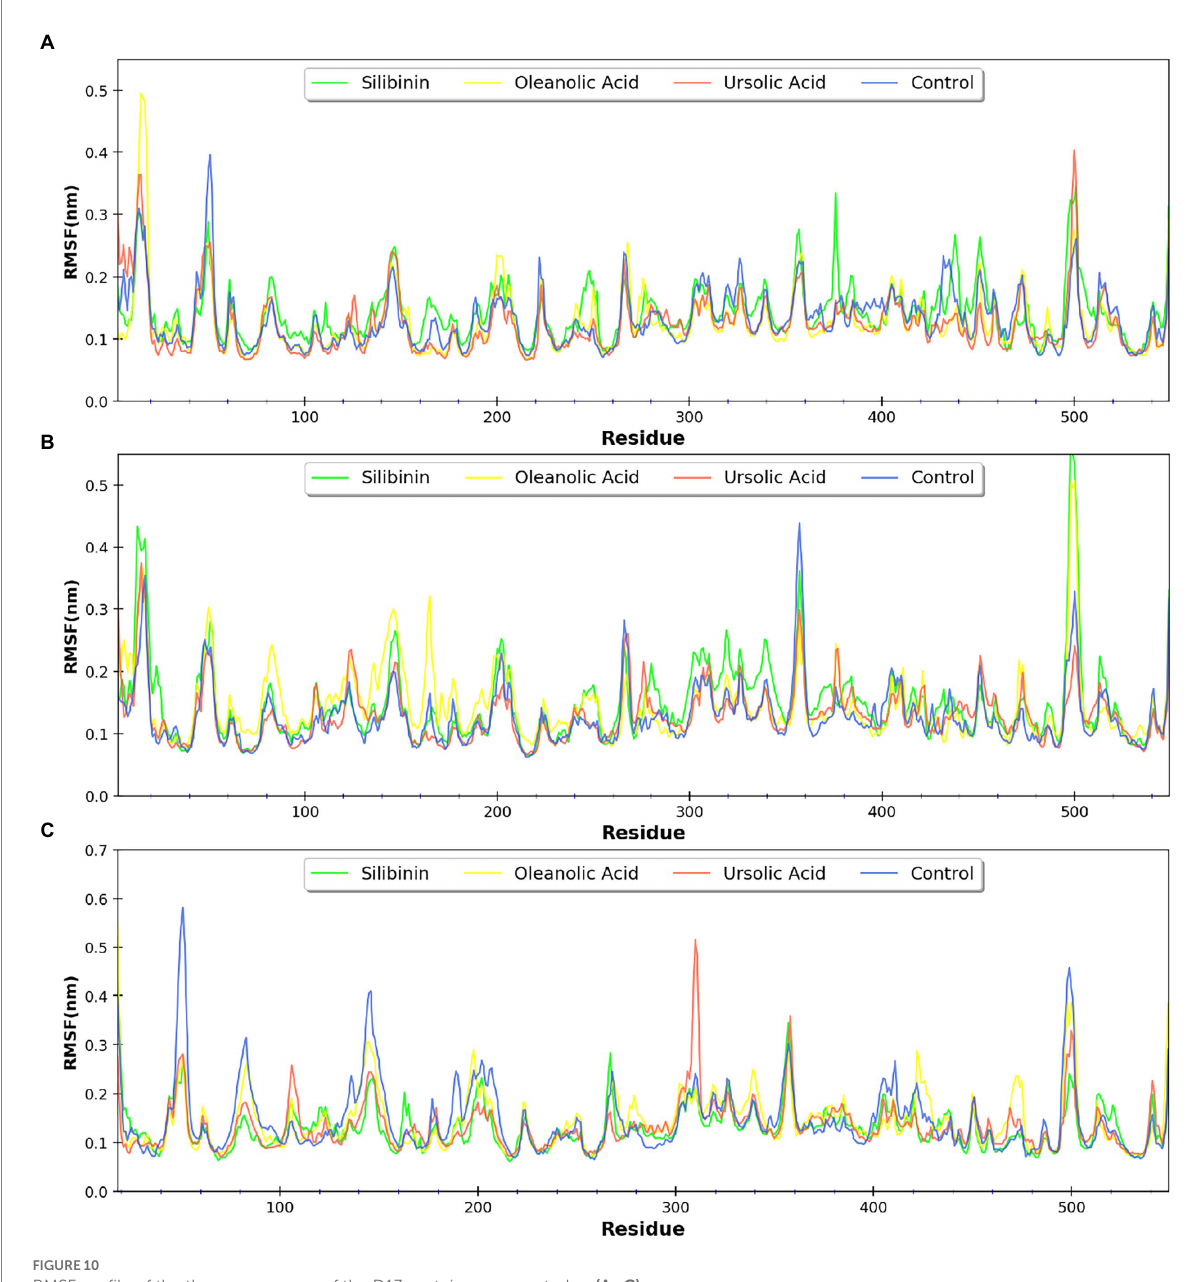
FIGURE 10 RMSF profile of the three monomers of the D13 protein respresented as (A–C) .